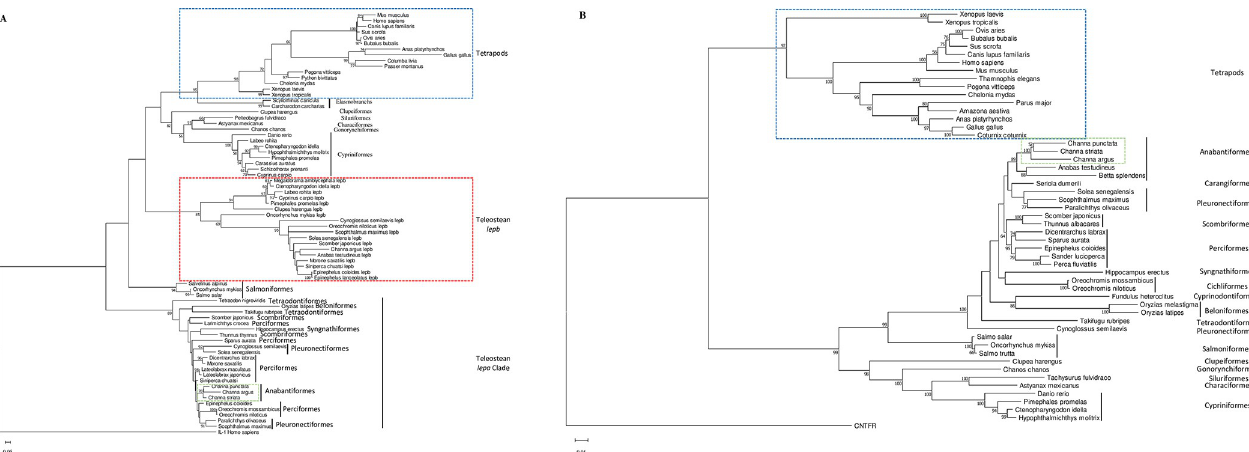
Fig 3. Molecular phylogenetic tree of A leptin and B leptin receptor. The tree was constructed using Maximum Likelihood method based on Jones-Taylor- Thornton substitution model. Numbers over nodes represent confidence interval obtained by bootstrapping (1000 replicates). The scale along the branch length represents number of substitutions per site (MEGA 11). The order of fishes is mentioned besides the name of organism. The cluster of tetrapods is boxed with blue color while that of C . punctata with green color. Red box is used to mark Lepb sequence. There were 74 and 52 protein sequences in Lep and Lepr phylogenetic trees, respectively.